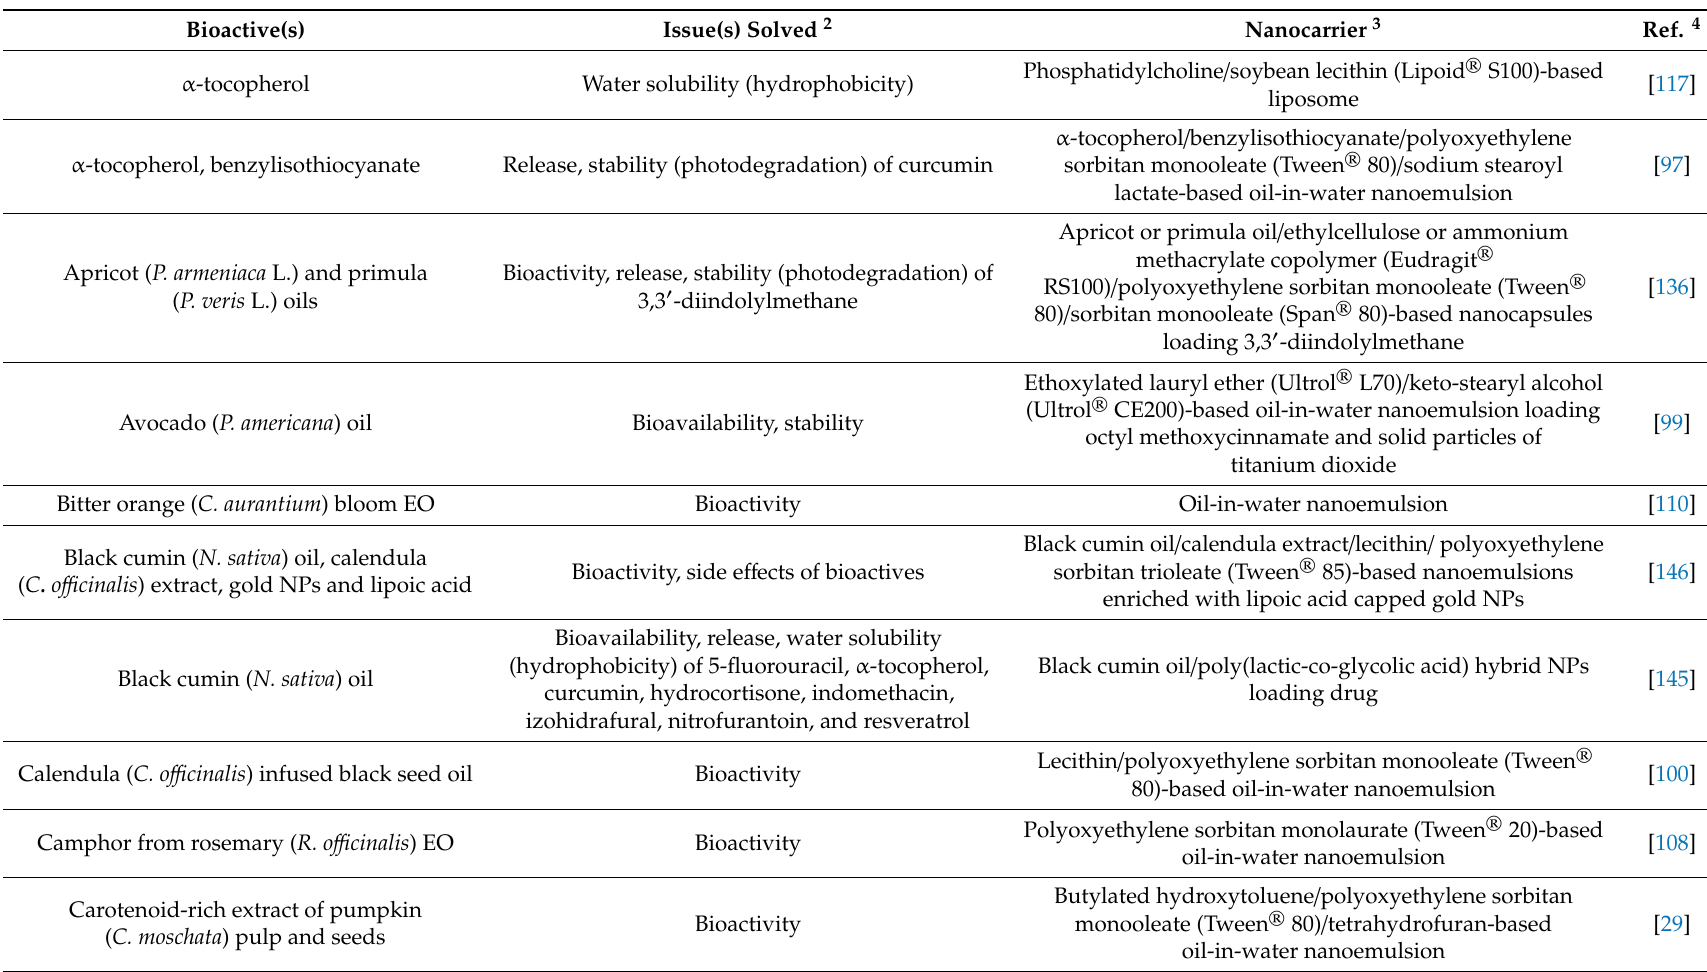
Table 1. Nanoformulations improving nutraceutical vegetable oil-based bioactives or vegetable-oil-derived bioactives enhancing drug activity 1